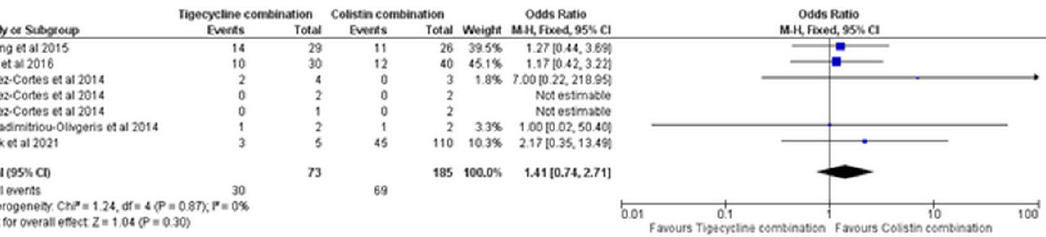
Figure 10. Overall mortality of tigecycline combination versus colistin combination [14,16,17,19–21,24]. The 30-day mortality did not also differ between the study combinations, based on